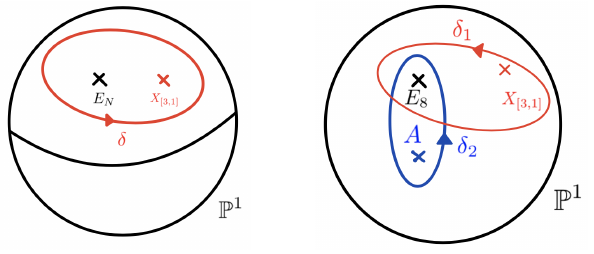
ˆ E N (left) and for the loop